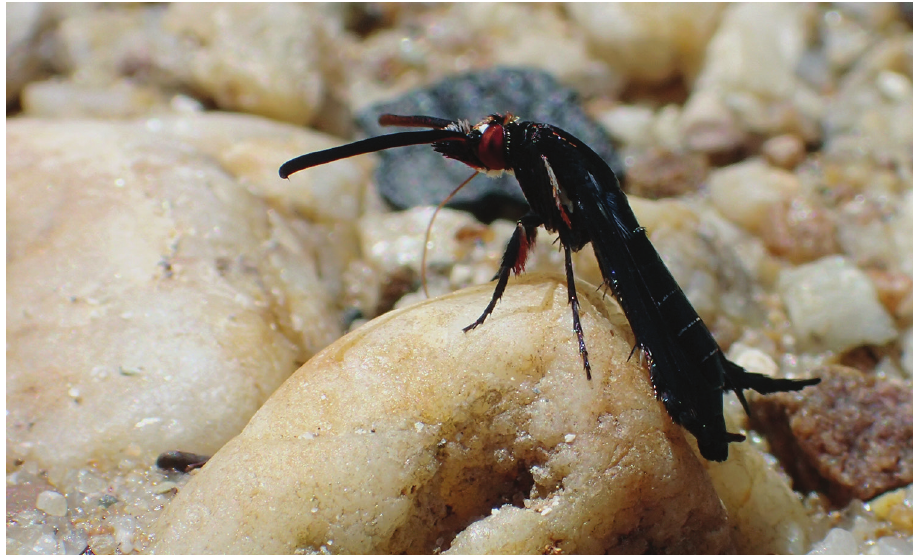
Figure 2. Pyrophleps ellawi puddling on a river bank. Note the curled-up hind leg